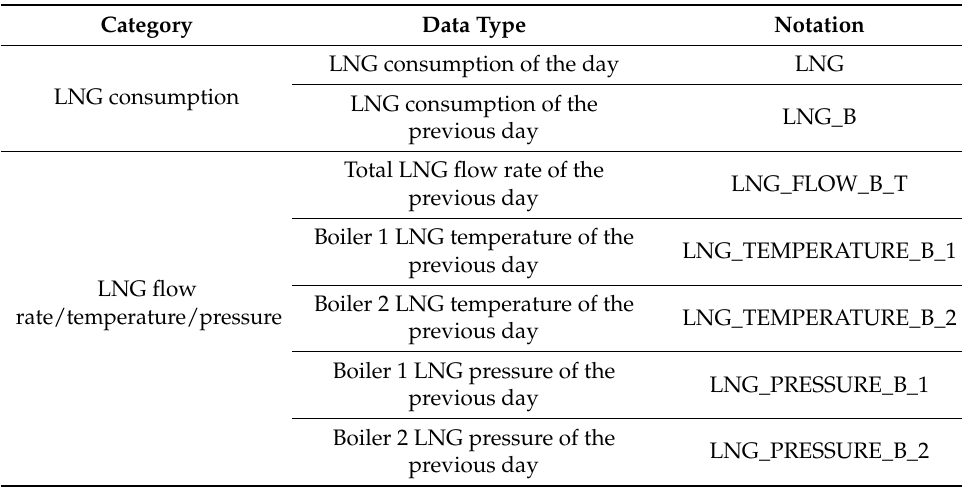
Table 6. Data for LNG consumption